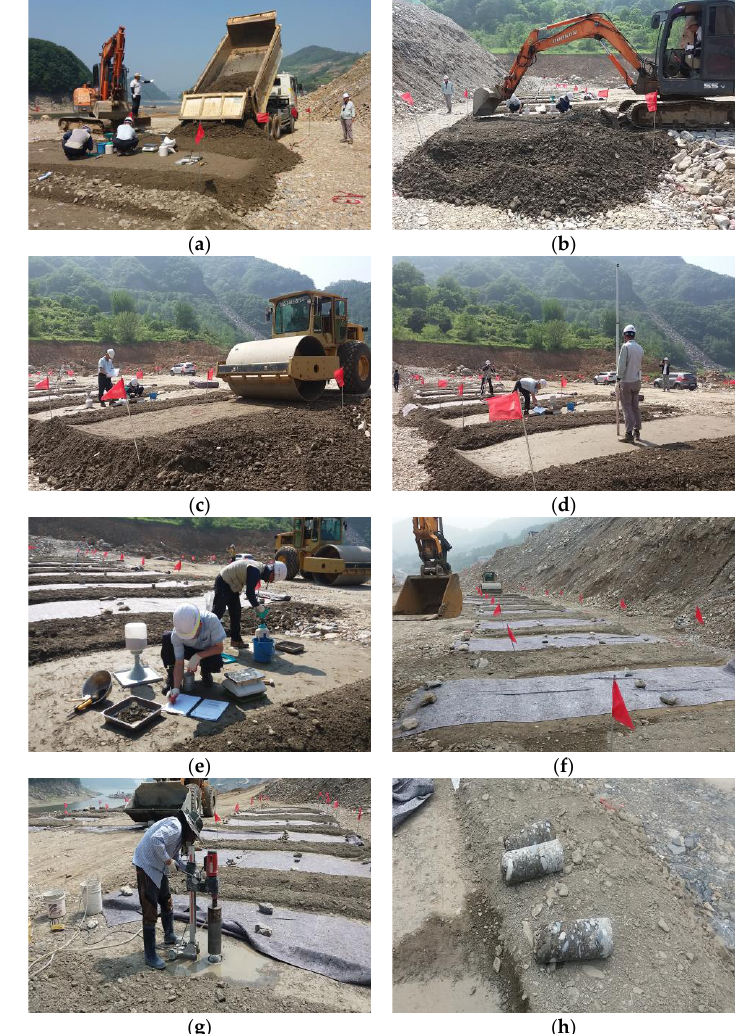
Figure 3. Field test construction and core collection. ( a , b ) Material transportation and placement; ( c ) compaction by vibration roller; ( d ) measurement of lift thickness; ( e ) measurement of field compaction (sand cone method); ( f ) curing after compaction; ( g ) core collection; ( h ) core aged 28 d.